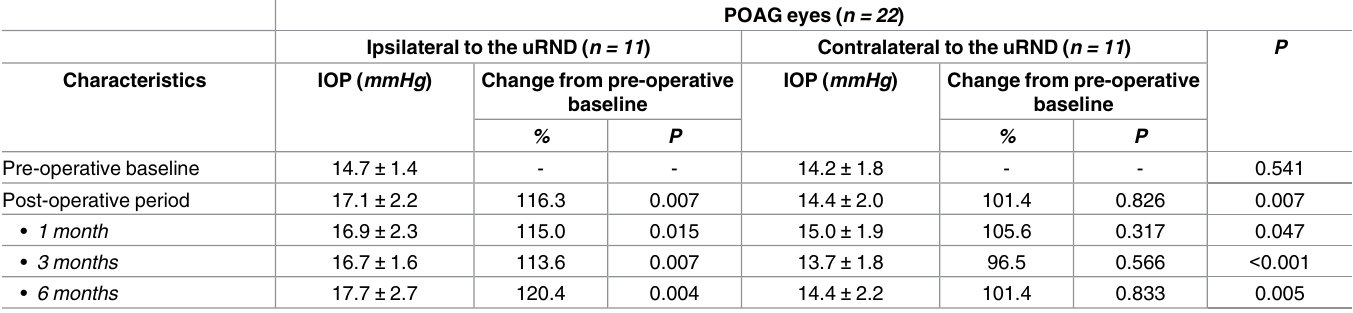
Table 3. IOP changes in latanoprost-treated-POAG eyes after the uRND.